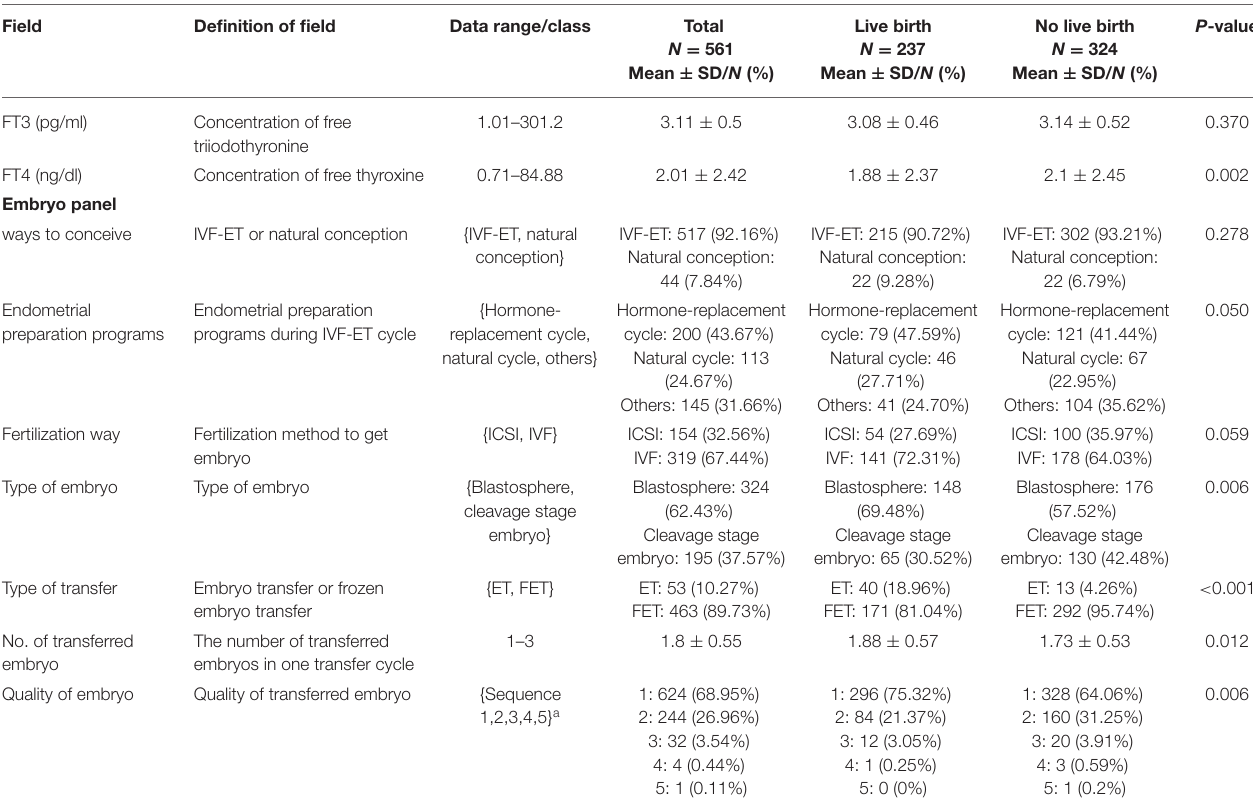
( Figure 2 ), endometrial immunology ( Figure 3 ), and the combination of all three immunological data panels ( Figure 4 ). A summary of prediction accuracy using various data panels is shown in Table 3 . Four output labels were used for prediction, namely, biochemical pregnancy, clinical pregnancy, ongoing pregnancy, and live birth. The ROC curves during the model training generally had AUC values exceeding 0.9, for each immunological panel. The AUC values decreased during testing. In terms of predicting biochemical pregnancy, the AUC of prediction using the endometrial immunology panel was higher (AUC = 0.766, accuracy: 73.0%) compared to the AUC of the panel using autoantibodies (AUC = 0.447, accuracy: 70.3%) and peripheral immunology panel (AUC = 0.697, accuracy: 72.4%). The AUC of prediction using the autoantibodies panel was higher in predicting clinical pregnancy (AUC = 0.688, accuracy: live birth (AUC = 0.909, accuracy: 89.7%), compared to the AUC of the panels using peripheral immunology and endometrial immunology panel. Combining all three immunological data panels did not result in an increase of the AUCs of all four pregnancy